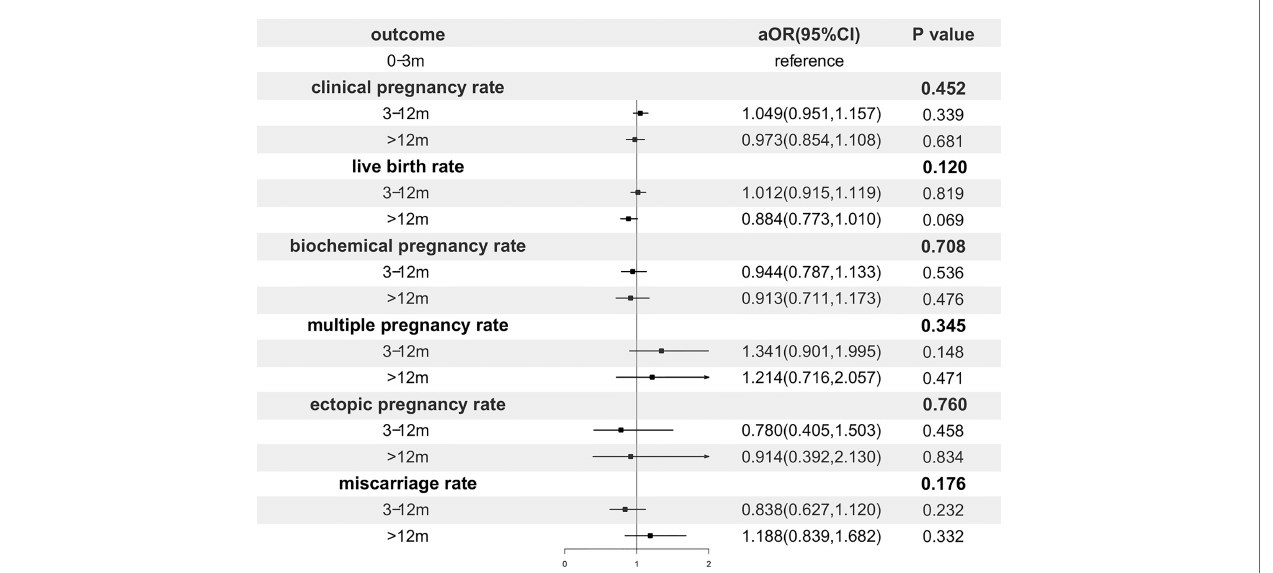
TABLE 3 | Perinatal outcomes of singletons born after single vitri fi ed embryo transfer cycles.